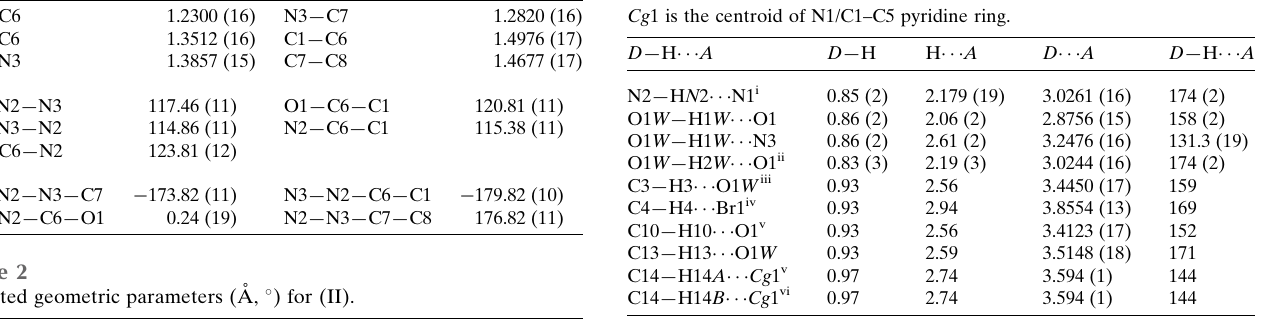
Table 1 Selected geometric parameters (A˚ , (cid:3) ) for (I).